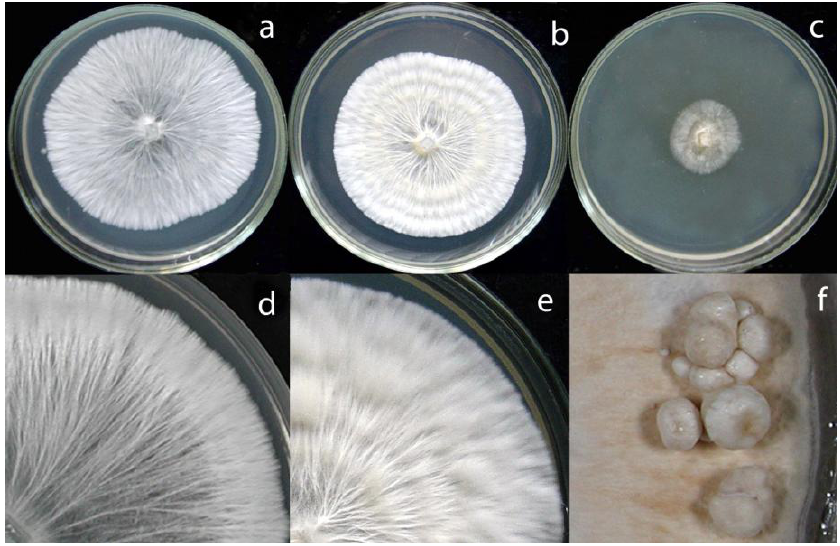
Figure 5 . Colony morphologies of C. strossmayeri strain 15-2C on (a, d) MEA, (b, e) PDA, and (c) GPA at 25 °C and pH 6.0 (a–c) on day 7 and (d, e) day 9 of cultivation; (f) primordia in fully established cultures of strain 15-2C after four weeks storage in a day/night regime at